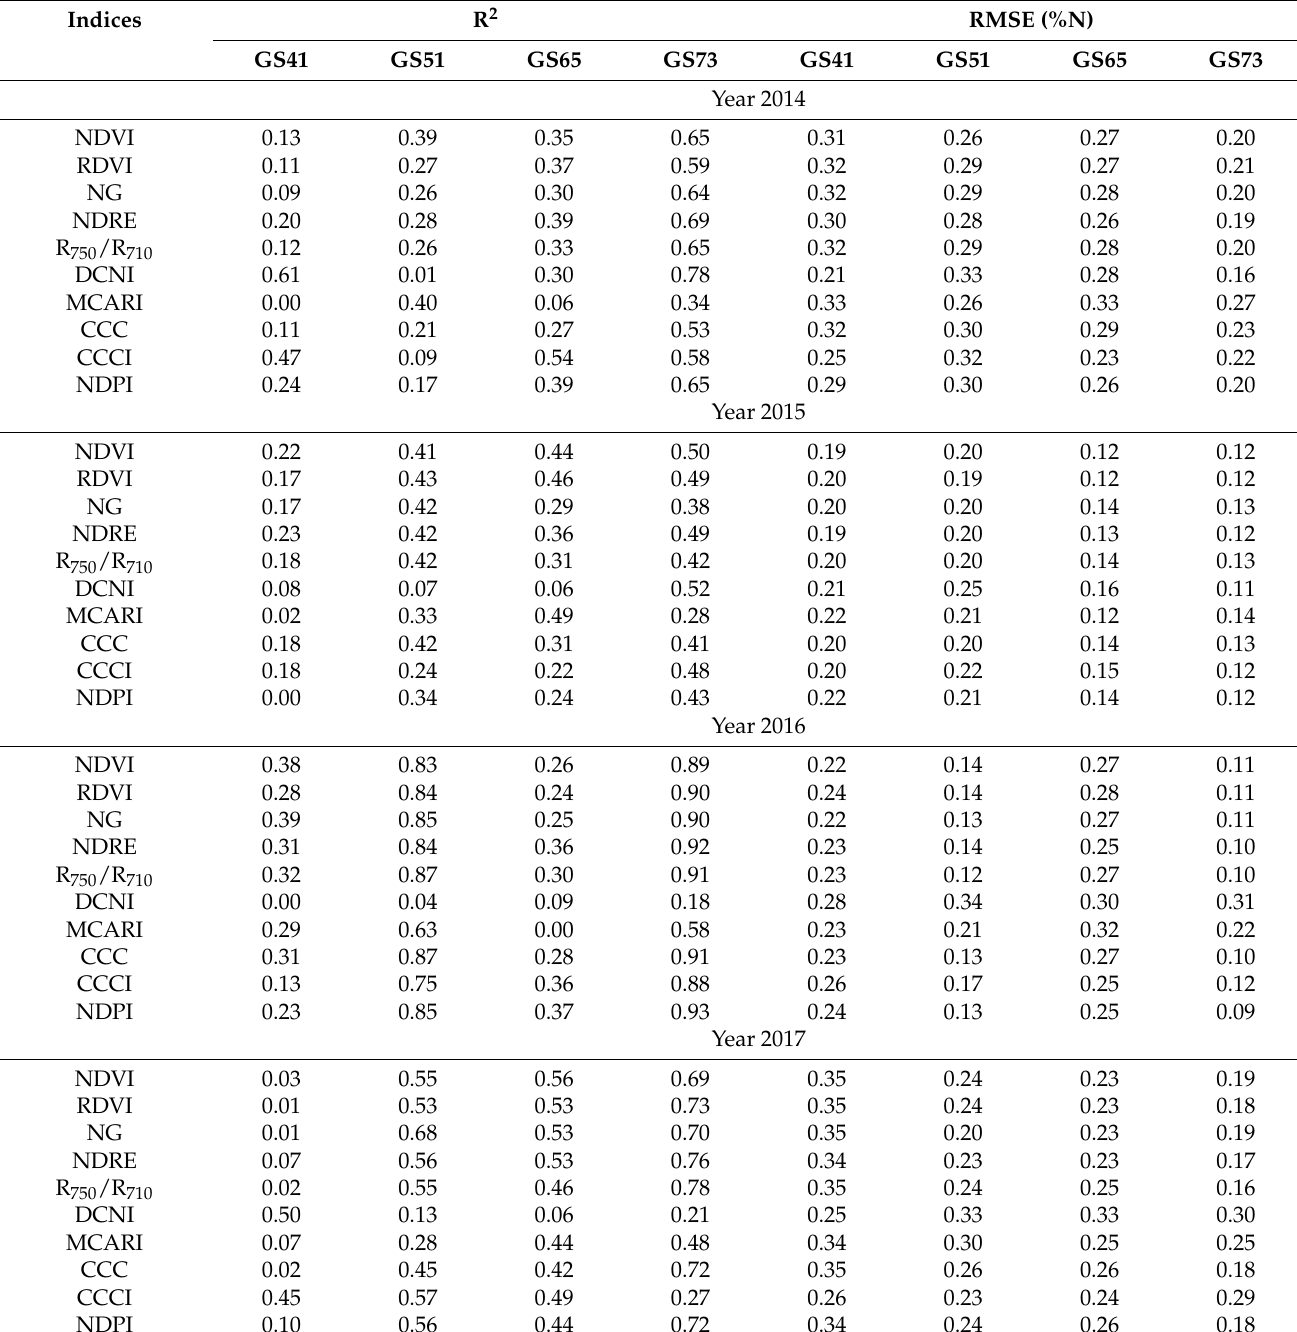
Table 3. Coefficient of determination (R 2 ) and root mean square error (RMSE) between hyperspectral indices and Grain N concentration at booting (GS41), heading (GS51), flowering (GS65), and early milk (GS73), over the 4 years studied. Indices